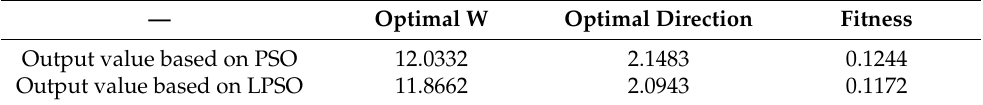
Table 4. Comparison between the two adaptive feature-extraction algorithms. —